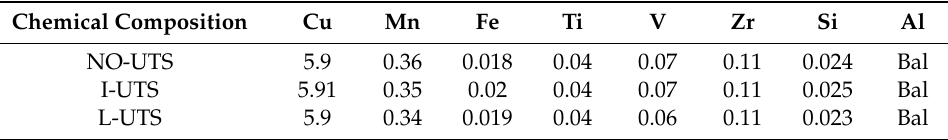
Table 1. Chemical composition of 2219 aluminum alloy (wt.